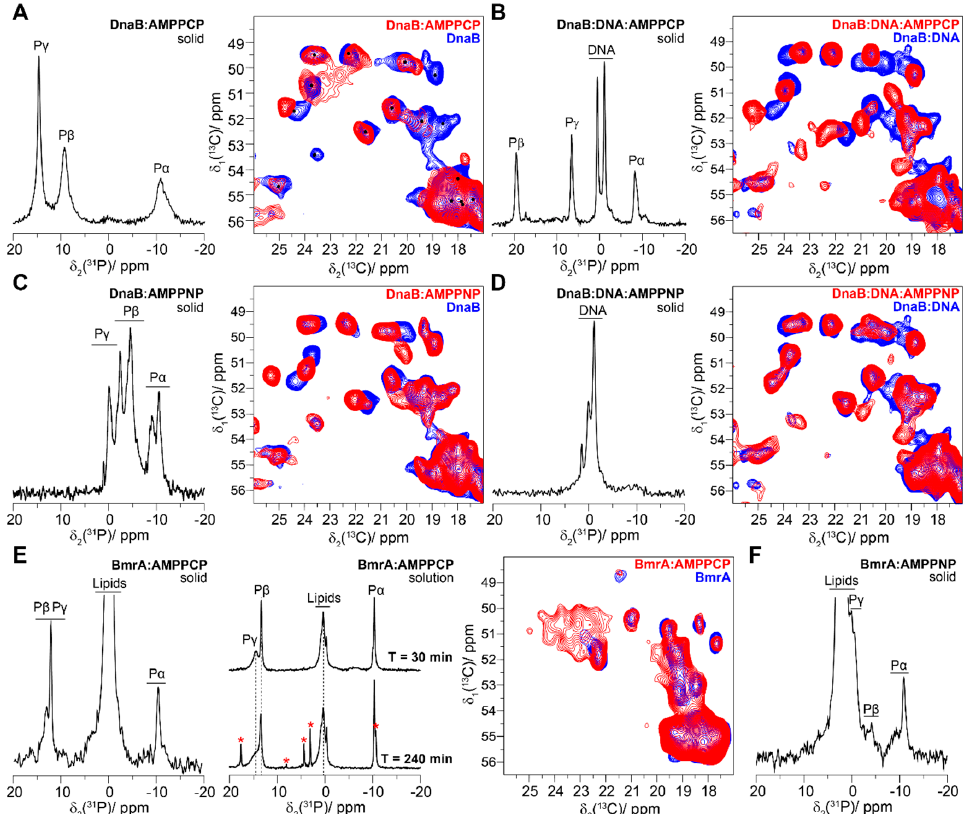
Figure 4. Pre-hydrolytic states using the systems DnaB and BmrA. 31 P one dimensional spectrum cross-polarization (1D CP) spectrum (left panel) and the alanine region of 13 C- 13 C-DARR spectra overlay (right panel) of DnaB (blue) and DnaB:AMPPCP (red) ( A ), DnaB:DNA (blue) and DnaB:DNA:AMPPCP (red) ( B ), DnaB (blue) and DnaB:AMPPNP (red) ( C ), DnaB:DNA (blue) and DnaB:DNA:AMPPNP (red) ( D ). 31 P 1D CP spectrum (left panel), 31 P 1D spectrum (middle panel) spectrum and overlay of the alanine region of 13 C- 13 C-DARR spectra (right panel) of BmrA:AMPPCP (red) and BmrA (blue) ( E ). Red stars indicate hydrolysis products of AMPPCP. 31 P 1D CP spectrum of BmrA:AMPPNP ( F ). Spectra in ( A ) and ( B ) were adapted from Wiegand et al. 2019 [82] (http://creativecommons.org/licenses/by/4.0/.), spectra ( C ) and ( D ) were adapted with permission from Wiegand et al. 2016 [38]. Panels ( E ) and ( F ) on BmrA represent original data; Red stars (*) indicate hydrolysis products of AMPPCP.